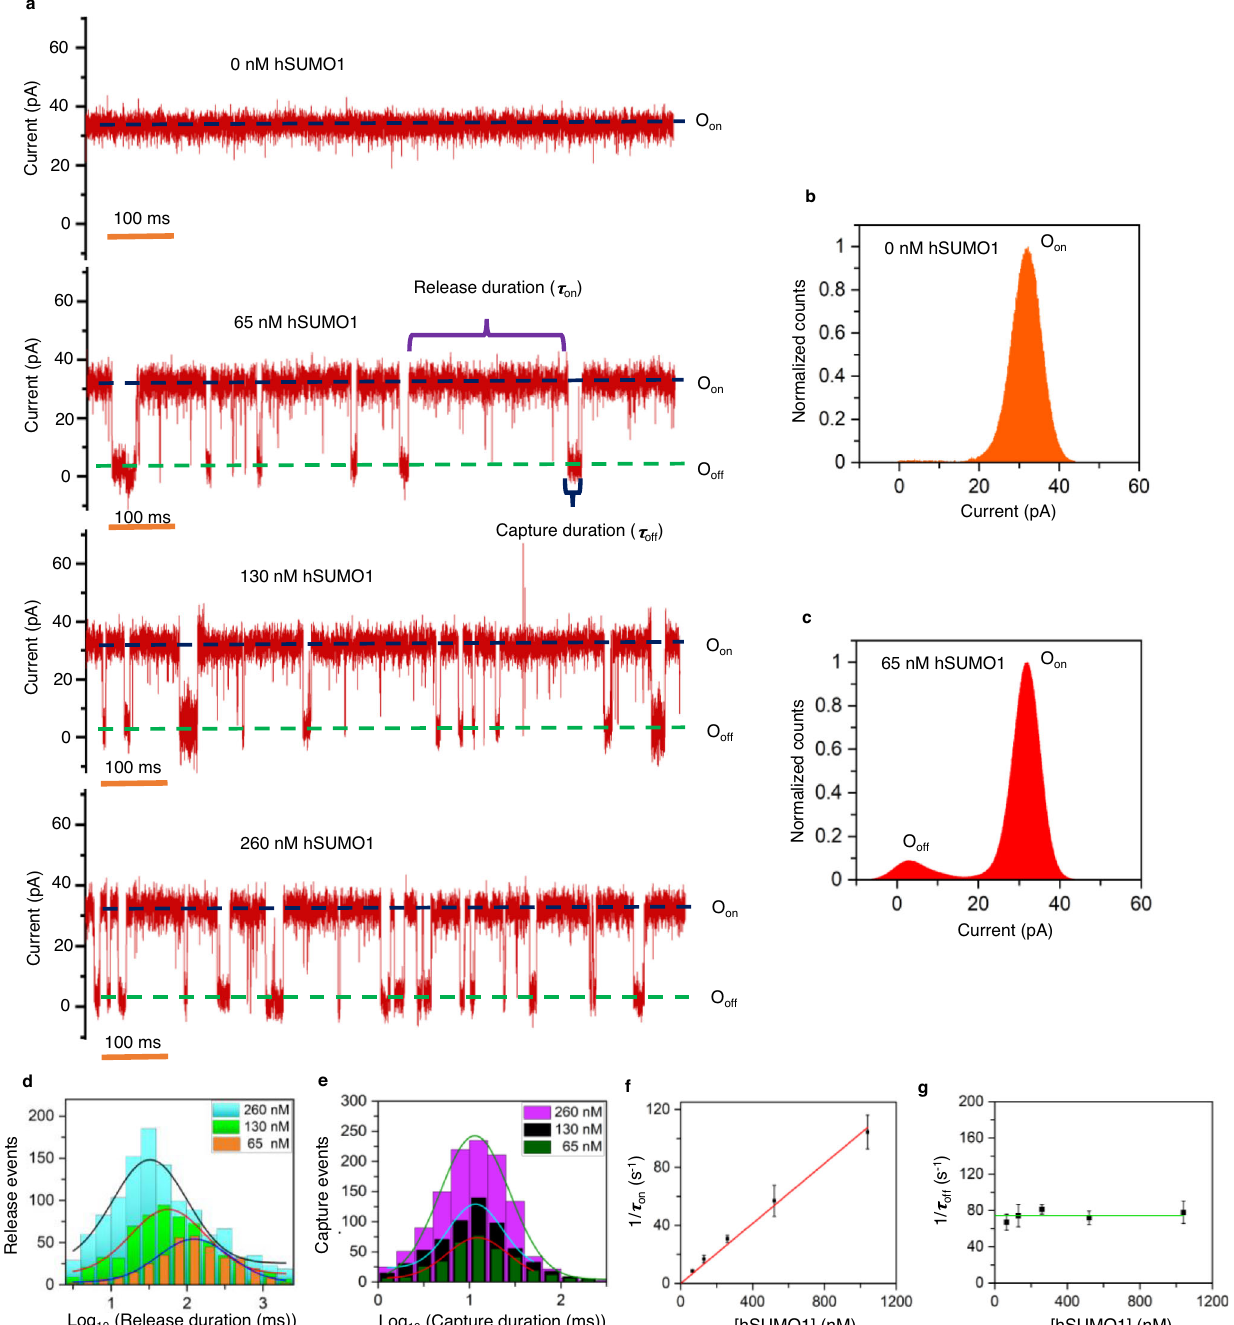
Log 10 (Release duration (ms)) Fig. 2 | Real-time and label-free detection of hSUMO1. a Representative single- channel electrical traces (in red) of FN3SUMO-tFhuA in the presence of 0, 65, 130, and260nMhSUMO1.O on andO off arethehSUMO1-releasedandhSUMO1-captured substates, respectively. τ on and τ off are the durations of the hSUMO1-released and hSUMO1-captured events, respectively. These single-channel electrical signatures were replicated i n n =3 independent experiments. The applied transmembrane potential was +40mV. Single-channel electrical traces were further low-pass fi l- teredat3kHzusingan8-poleBessel fi lter. b Acurrenthistogram(inorange)ofthe O on substateofFN3SUMO-tFhuA.Thecurrentamplitude(mean±s.e.m.)oftheO on substate was 32.1±0.1 pA. c A current histogram (in red) of the O on and O off sub- states of FN3SUMO-tFhuA at 65nM hSUMO1. The current amplitude (mean± s.e.m.)of the O off substatewas2.9±0.1pA. d Histogramsof τ on atvarioushSUMO1